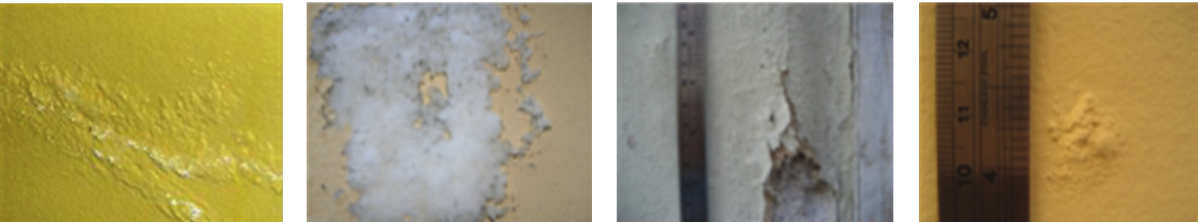
Figure 1: Swelling, e ffl orescence, cracking, and blistering [16]. Table 1: Classification of